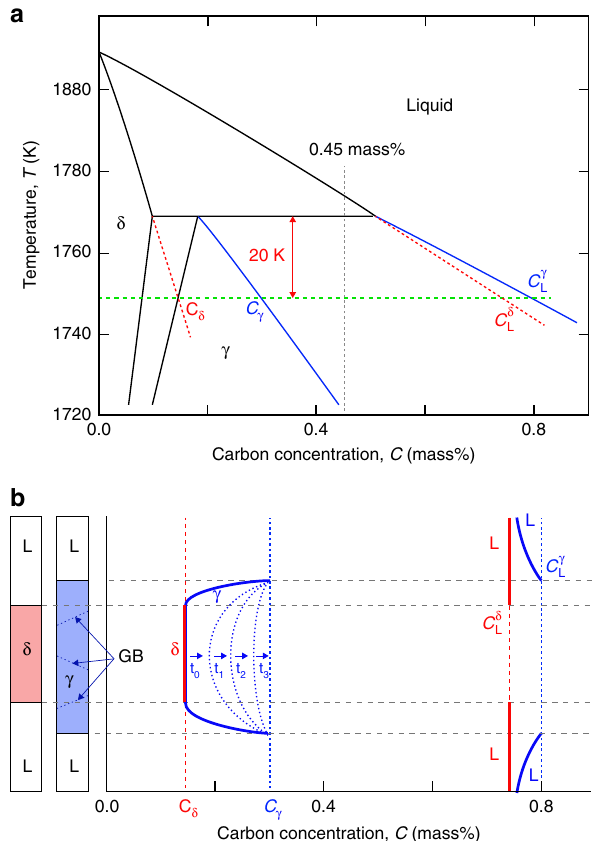
Fig. 4 Diffusion-controlled melting at γ grain boundary. a Phase diagram of Fe – C alloy system. A massive-like transformation occurred at 20 K below the peritectic temperature (dashed red line). b Carbon concentration pro fi les before (red line) and after (blue lines) massive-like